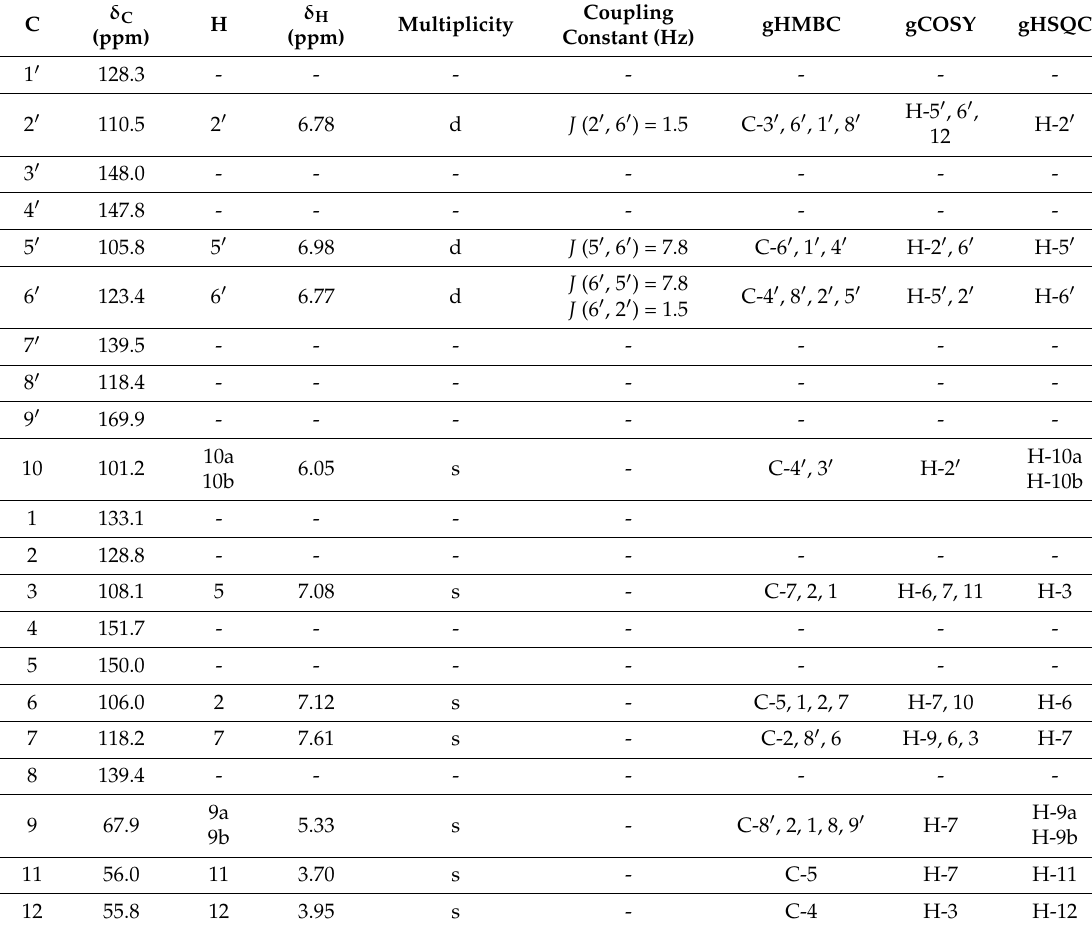
Table 1. Detailed NMR characteristics of justicidin B in CDCl 3 [9].